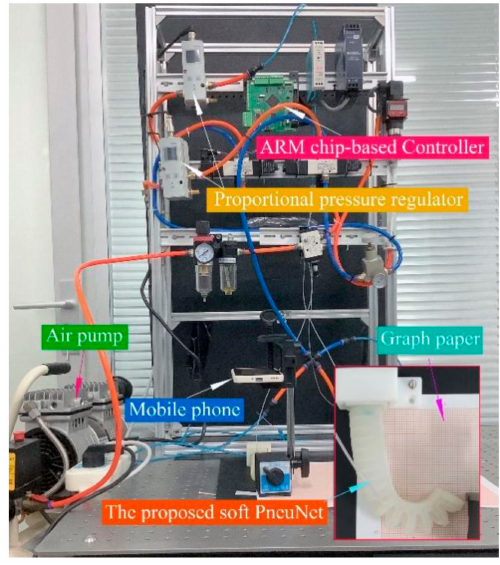
Figure 8. Experimental